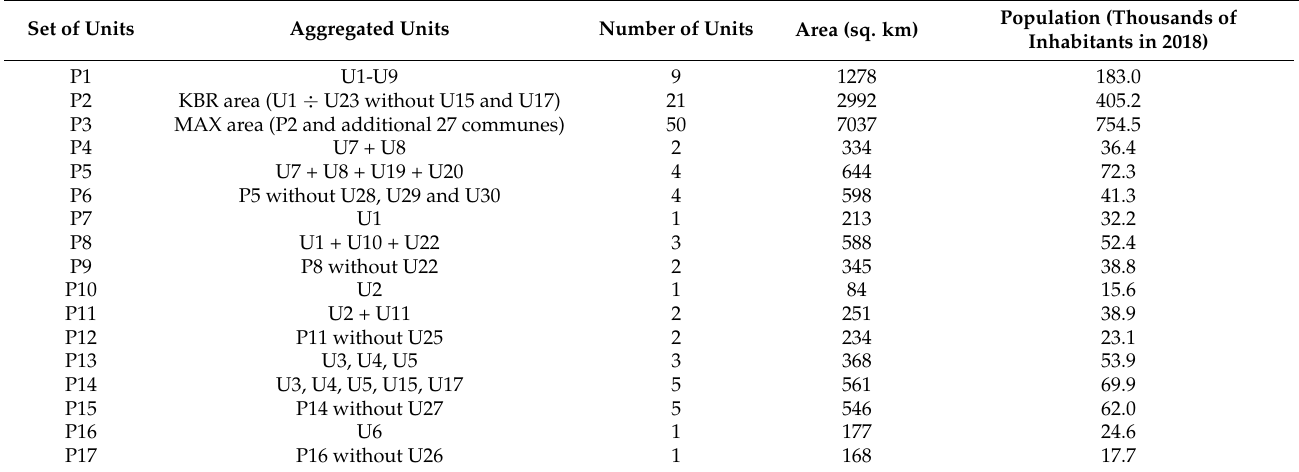
Table 5. Groups aggregating demographic parameters within administrative units.